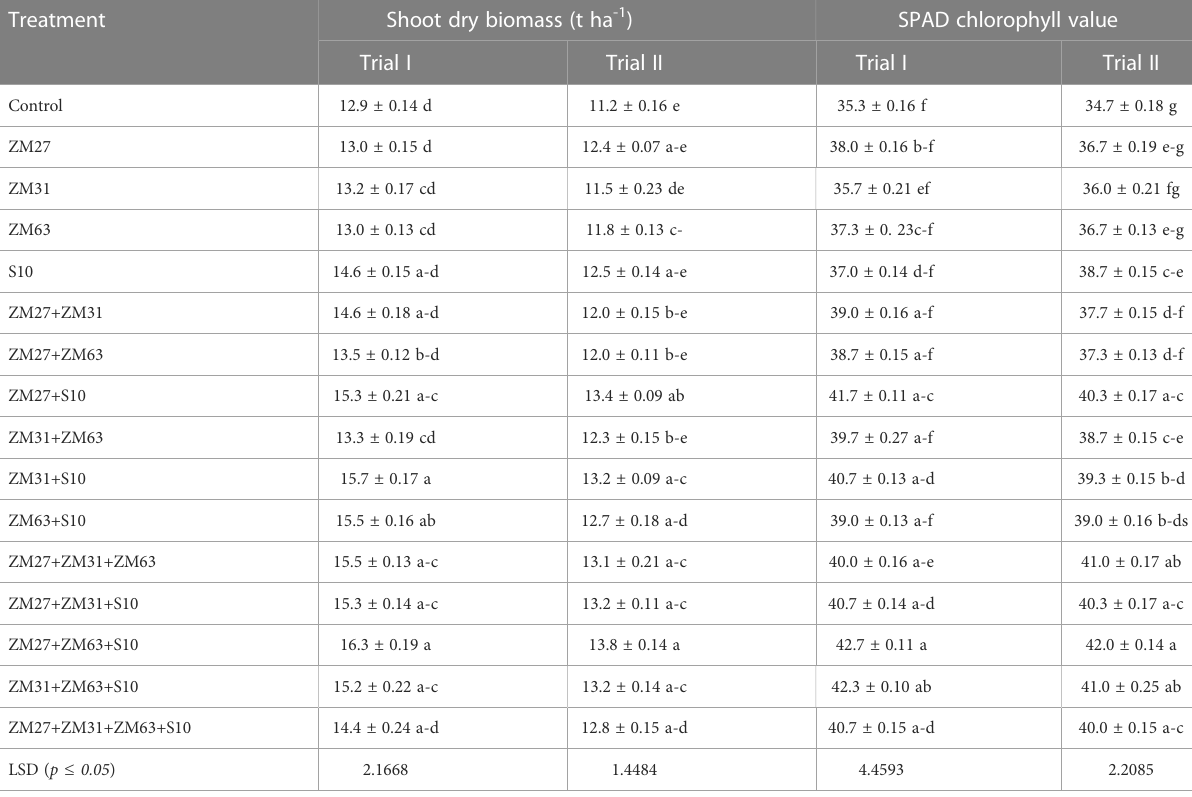
TABLE 4 Effect of novel bio inoculants on shoot dry biomass and SPAD value of maize in fi eld trials.